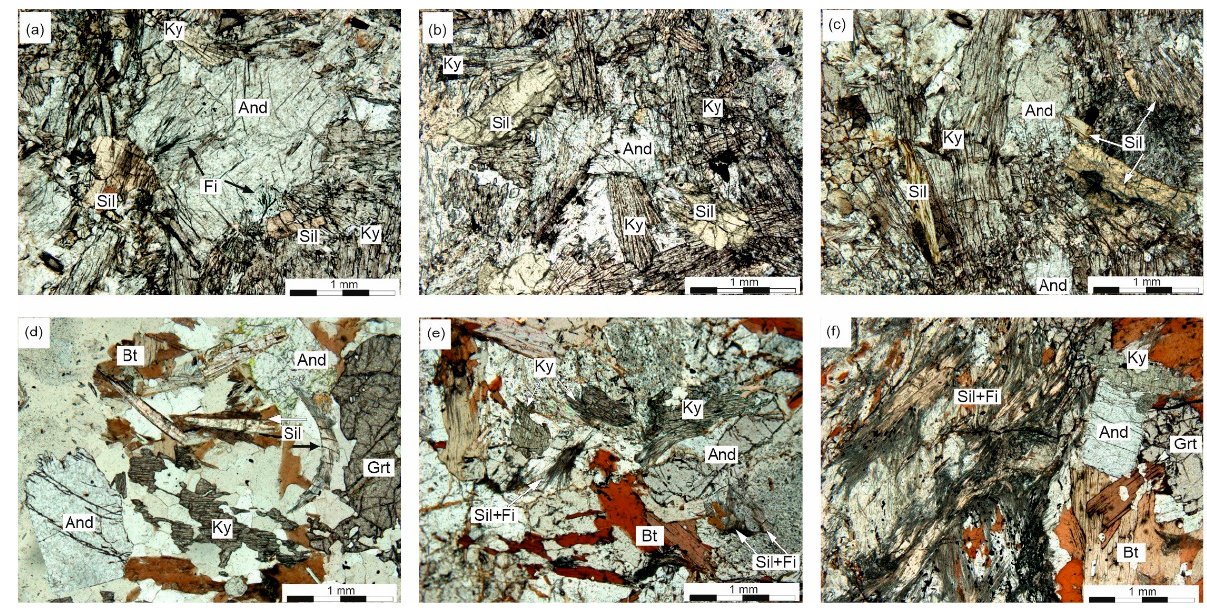
Figure 12. Photomicrographs showing the microtextural relationships among the Al 2 SiO 5 polymorphs—andalusite, sillimanite, and kyanite—in the study areas of the Teya complex. Prograde sequences involve different reaction replacements: (( a , b )—Mayakon) And → Ky → Sil ± Fi; (( c )—Polkan) And → Ky → Sil; (( d )—Chapa) And → Sil → Ky; and (( e , f )—Teya) And → Sil → Ky + Fi.